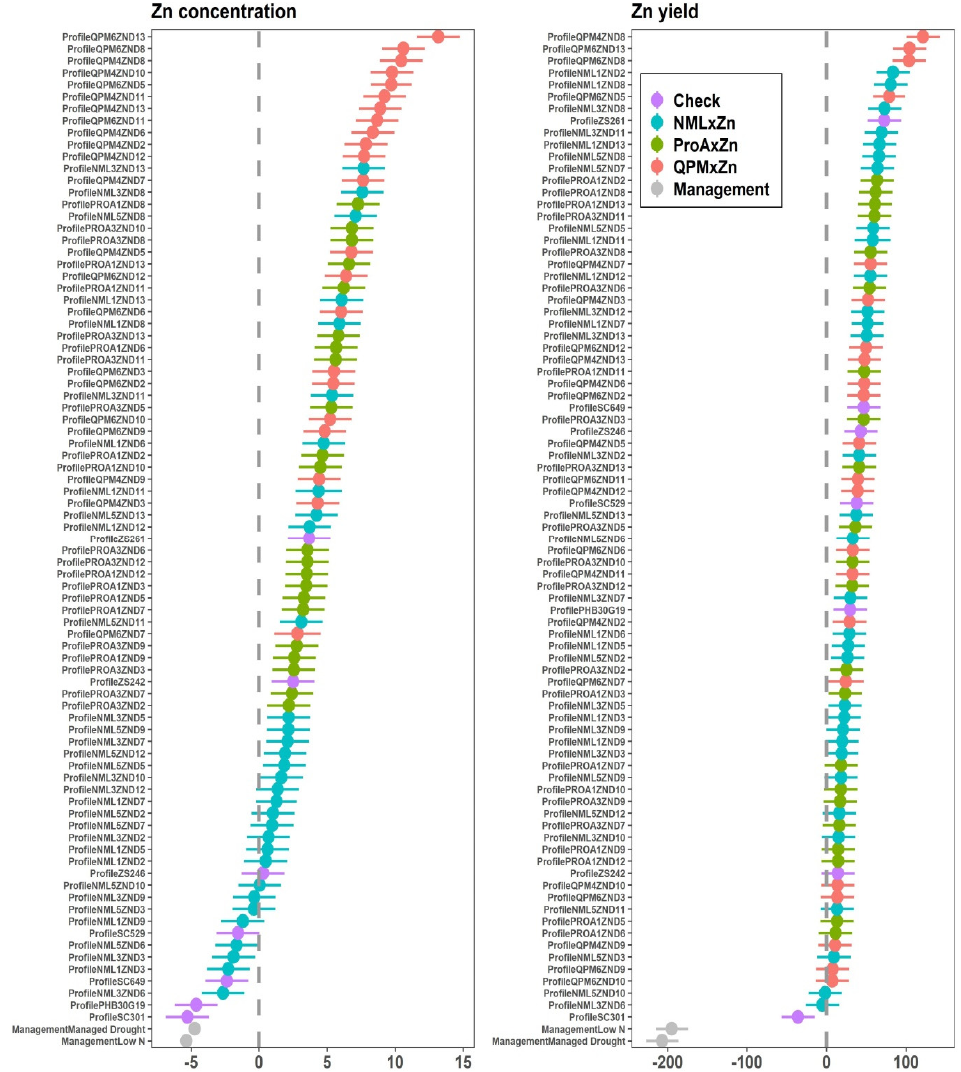
Figure 4. Nutritional profile showing Zn concentration versus Zn yield of testcross hybrids and checks grown under low N and managed drought conditions where optimum management was the reference.